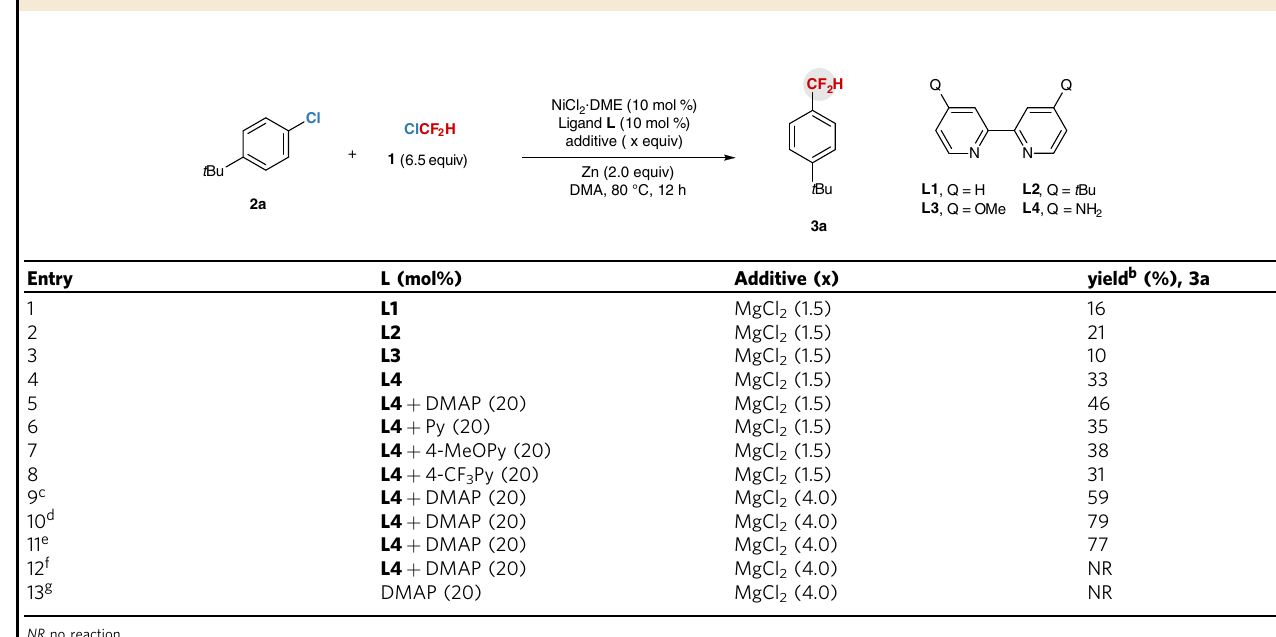
Table 1 Representative results for the optimization of Ni-catalyzed di fl uoromethylation of 2a with C1CF 2 H